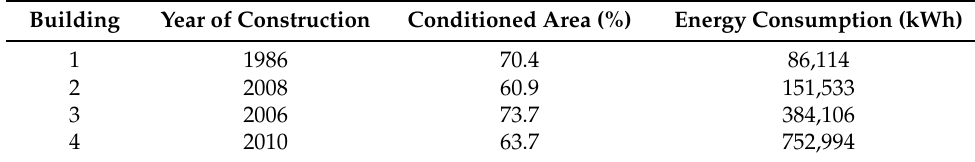
Table 6. Annual energy consumption of each building.